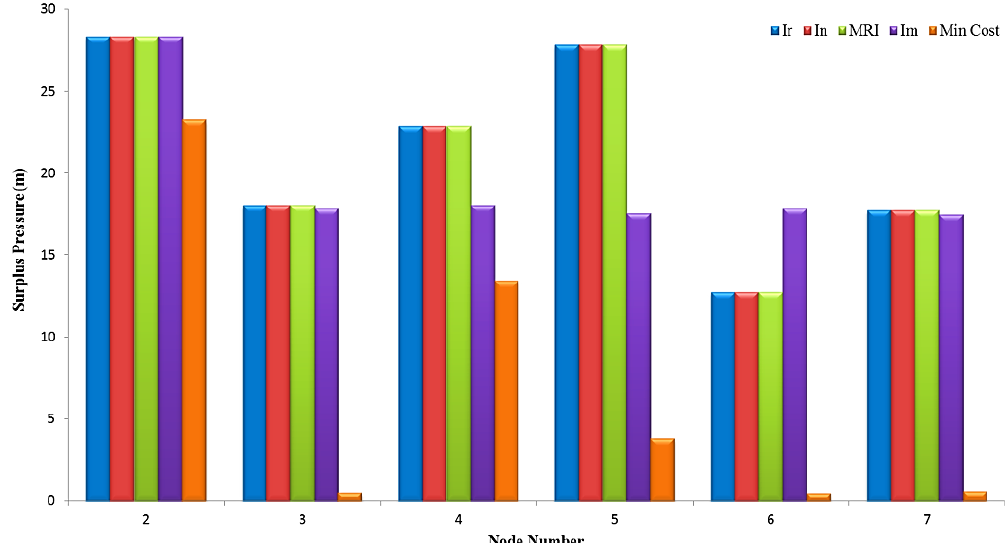
Figure 2. Surplus pressure of nodes in the two-loop network for solutions of maximum reliability criteria and minimum cost.